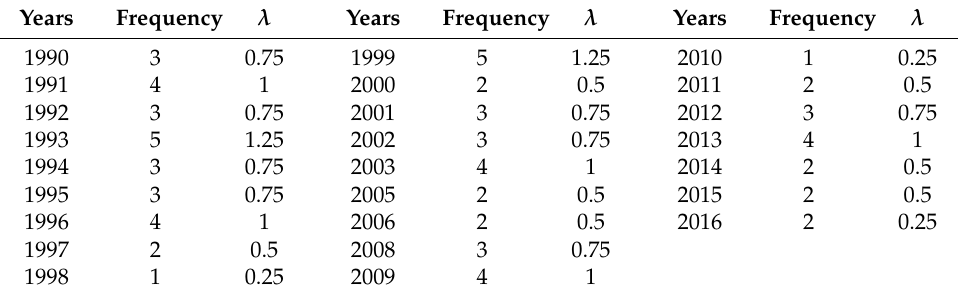
Table 1. Frequency of typhoons and Poisson intensity λ